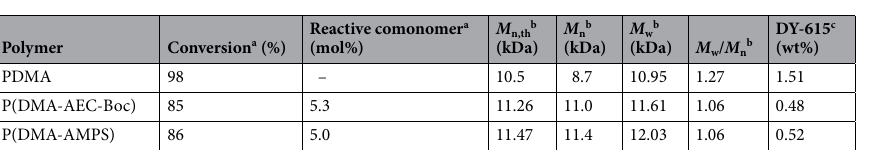
Table 1. Characterization of polymers used for modification of UCNP. According to a1 H NMR, b size exclusion chromatography, c UV–Vis spectroscopy in methanol ( Ɛ = 200,000 l/mol·cm); M n,th —theoretical molar mass, M n and M w —number- and weight-average molar mass, respectively; PDMA—poly( N,N -dimethylacrylamide), AEC-Boc— tert -butyl[2-(acryloylamino)ethyl]carbamate, AMPS—2-(acryloylamino)-2-methylpropane-1- sulfonic